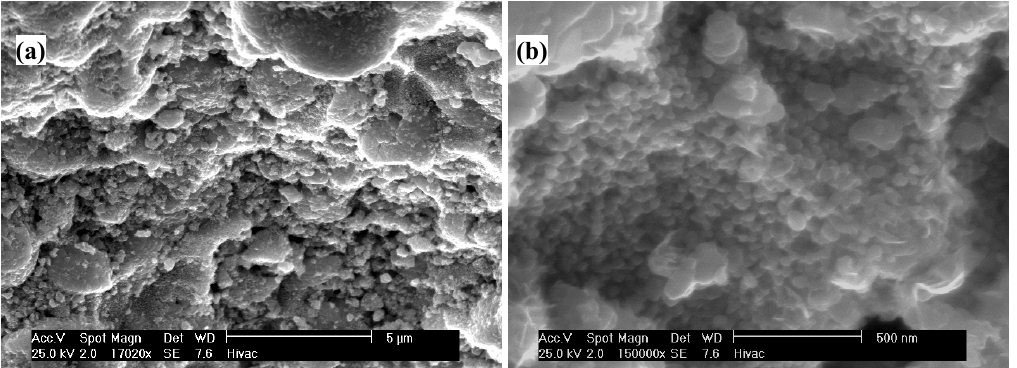
Figure 7. SEM images ( a – c ) and XRD pattern ( d ) of IF-WS rotary